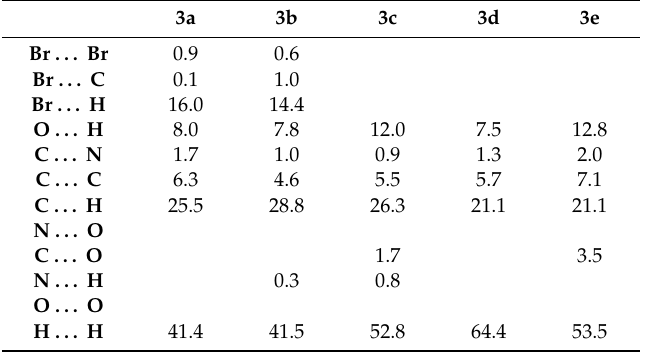
Figure 6. Summary of the intermolecular interactions and their percentages in the crystal structures of the studied compounds. Table 2. List of all intermolecular contacts and their percentages using Hirshfeld Topology